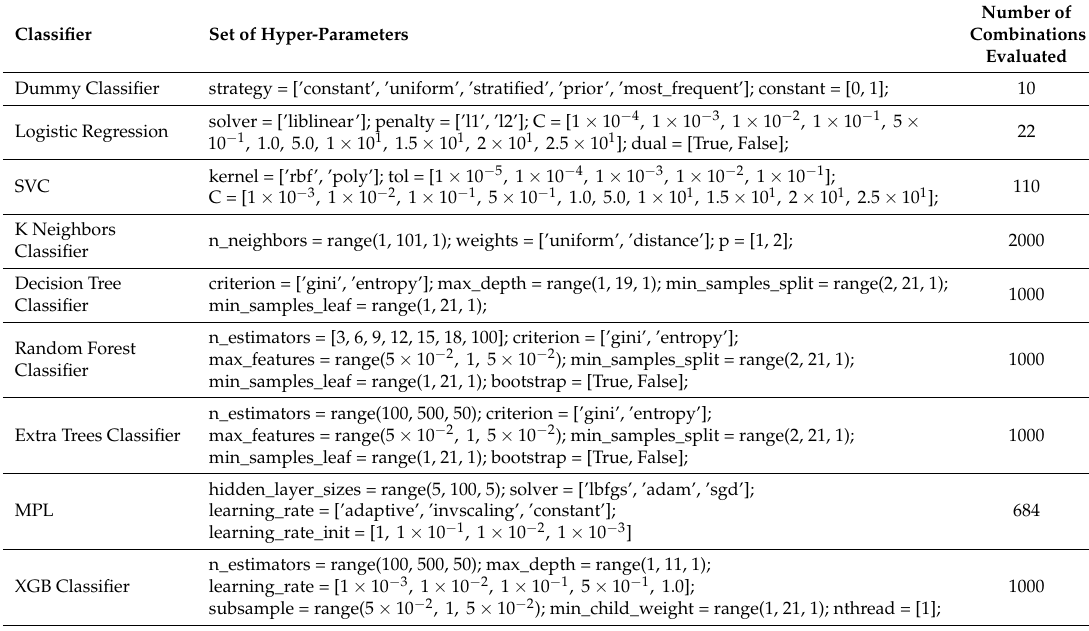
Table 1. List of tested classifiers and their corresponding sets of hyper-parameters and values. For more information about each hyper-parameter, please visit